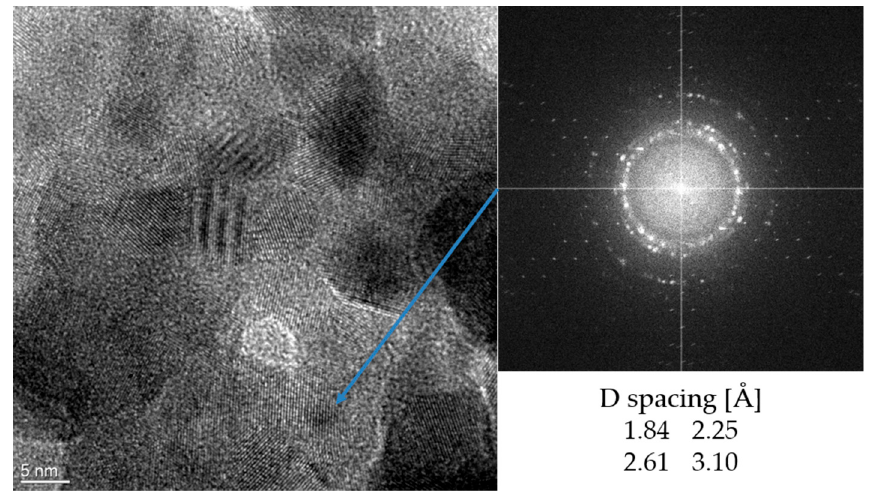
Figure 20. Selected Area Electron Diffraction (SAED) and TEM analyses carried out on a Rh containing area of the spent not-reduced CZOm supported catalyst after reaction at high temperature.